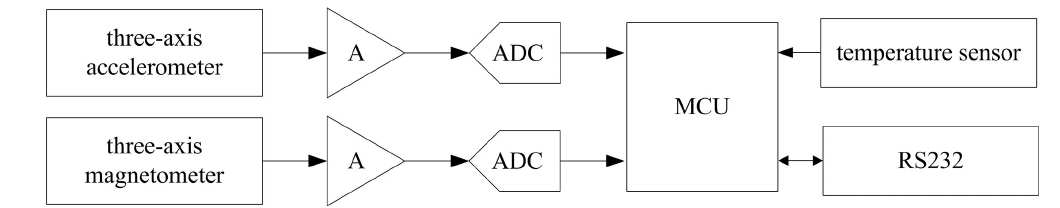
Figure 5. Block diagram of the hardware of the attitude